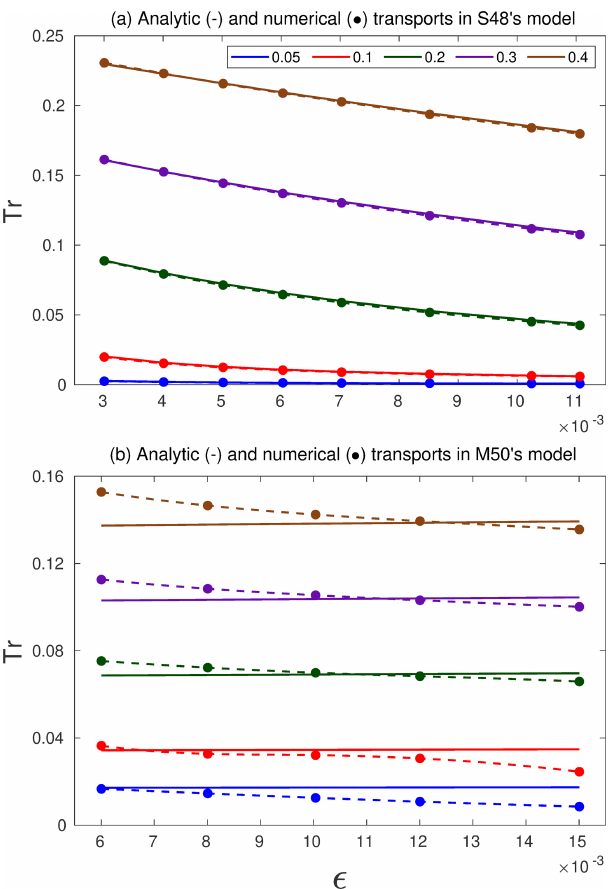
Figure 3. Comparison between analytically (solid lines) and nu- merically (dots) calculated values of transport (Tr) as a function of (cid:15) for different values of δ in (a) S48’s and (b) M50’s models. The dashed lines depict the cubic-spline-interpolated curves between the numerically calculated transports